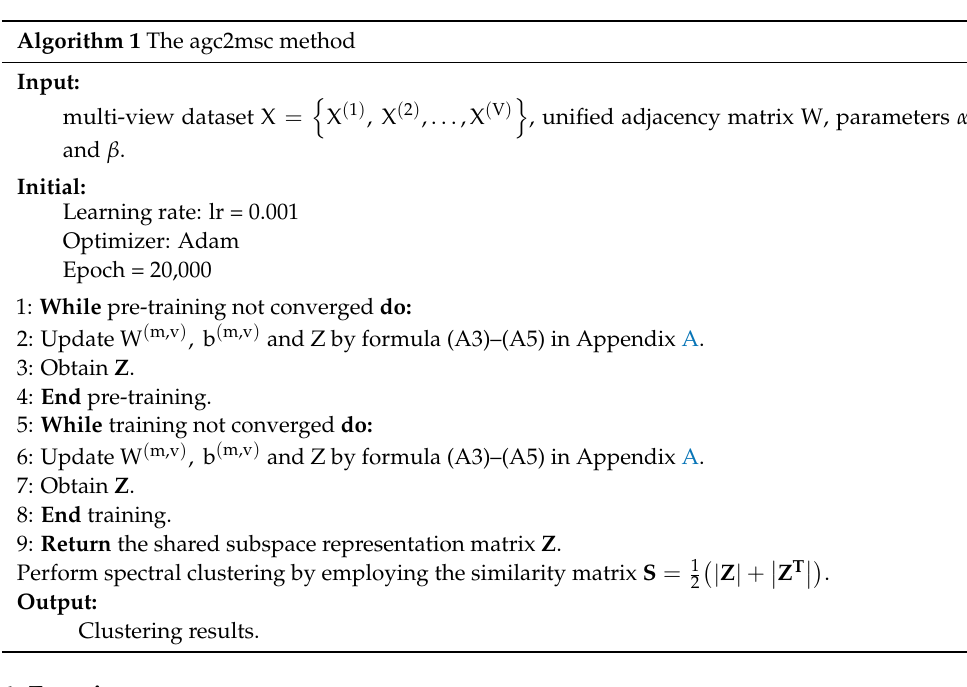
Algorithm 1 The agc2msc